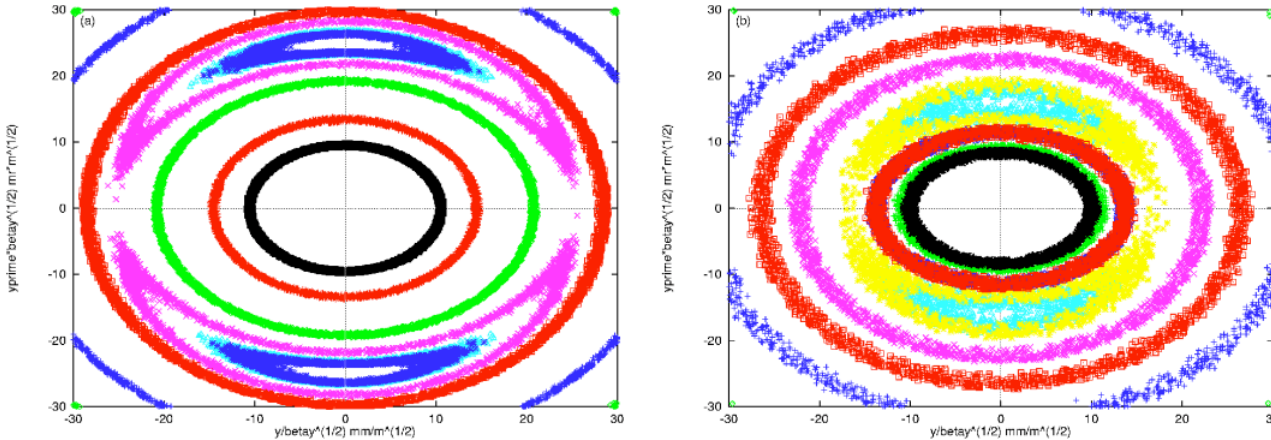
FIG. 7. (Color) PCM Poincaré plots of vertical phase space for beam intensities corresponding to (a) 1 3 10 14 particles and (b) 4 3 10 14 particles and 10% rms